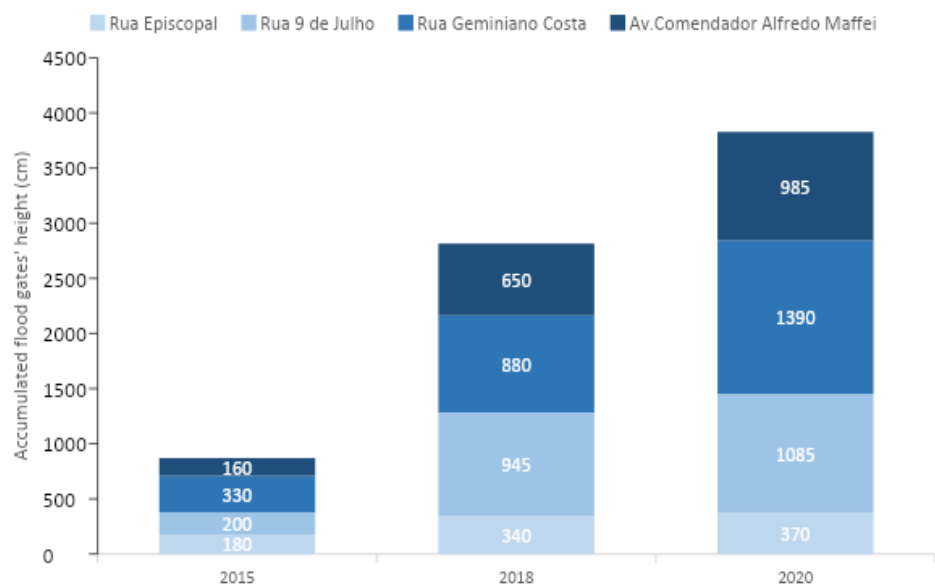
Figure 8. Sum of floodgate height separated by the streets considered in this study. The values increased the most in the streets 9 de Julho, Geminiano Costa and Comendador Alfredo Maffei after the event of 2015.